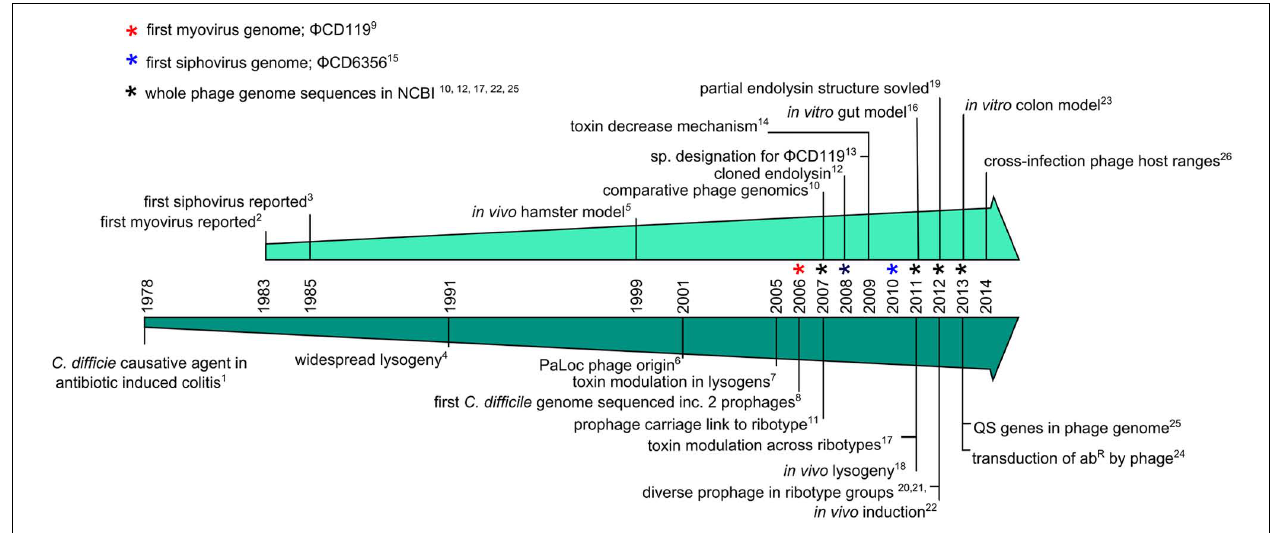
FIGURE 2 |Timeline charting major events of C. difficile phage research. Milestones are discussed in detail in the text and the references are as follows; (1) George etal., 1978, (2) Sell etal., 1983, (3) Mahony etal., 1985, (4) Nagy and Foldes, 1991, (5) Ramesh etal., 1999, (6) Tan etal., 2001, (7) Goh etal., 2005a, (8) Sebaihia etal., 2006, (9) Govind etal., 2006, (10)Goh etal., 2007, (11)Fortier and Moineau, 2007,